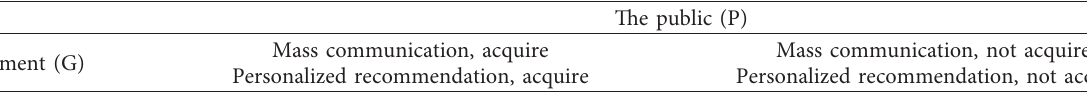
Table 2: The strategy matrix of two